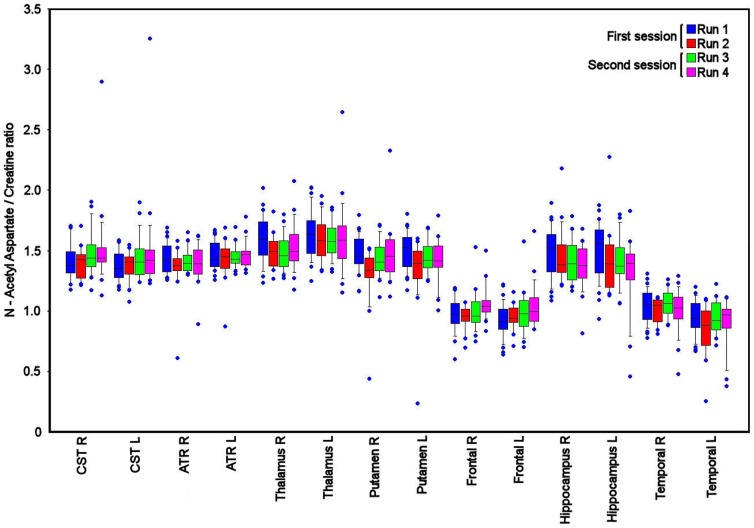
Variability in N Acetyl Aspartate/Creatine ratio measurements.Box and whisker plot for N Acetyl Aspartate/Creatine ratio for a selection of the regions of interest (ROI), including right (R) and left (L) corticospinal (CST), anterior thalamic radiation (ATR), thalamus, putamen, frontal lobe, hippocampus and temporal lobe. The spread of data within each ROI reflects inter subject variation, while the difference between runs 1 – 2 and 3 – 4 reflects within session reproducibility, and the change from first to second sessions reflects between session reproducibility. The central lines in each box denote median values, the lower and upper boundaries the 25th and 75th centile, the error bars the 10th and 90th centile, and the closed circles outlying data points.